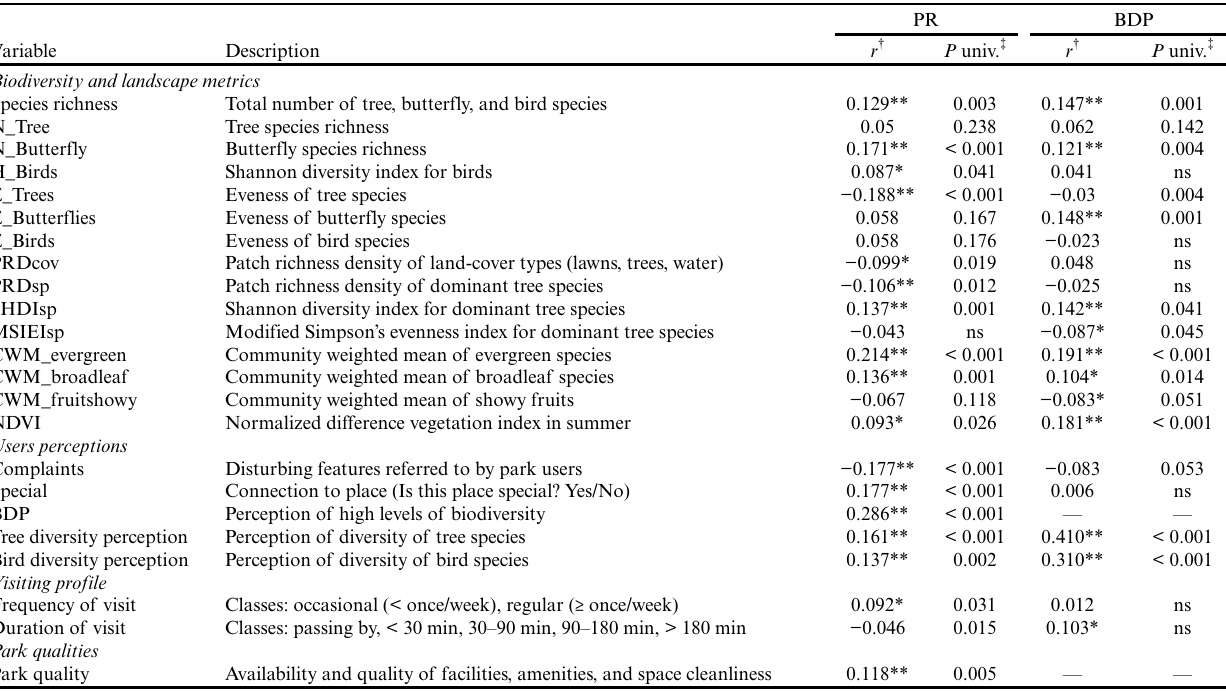
Table 3. List of the final set of variables used to model perceived restorativeness (PR) and biodiversity perception